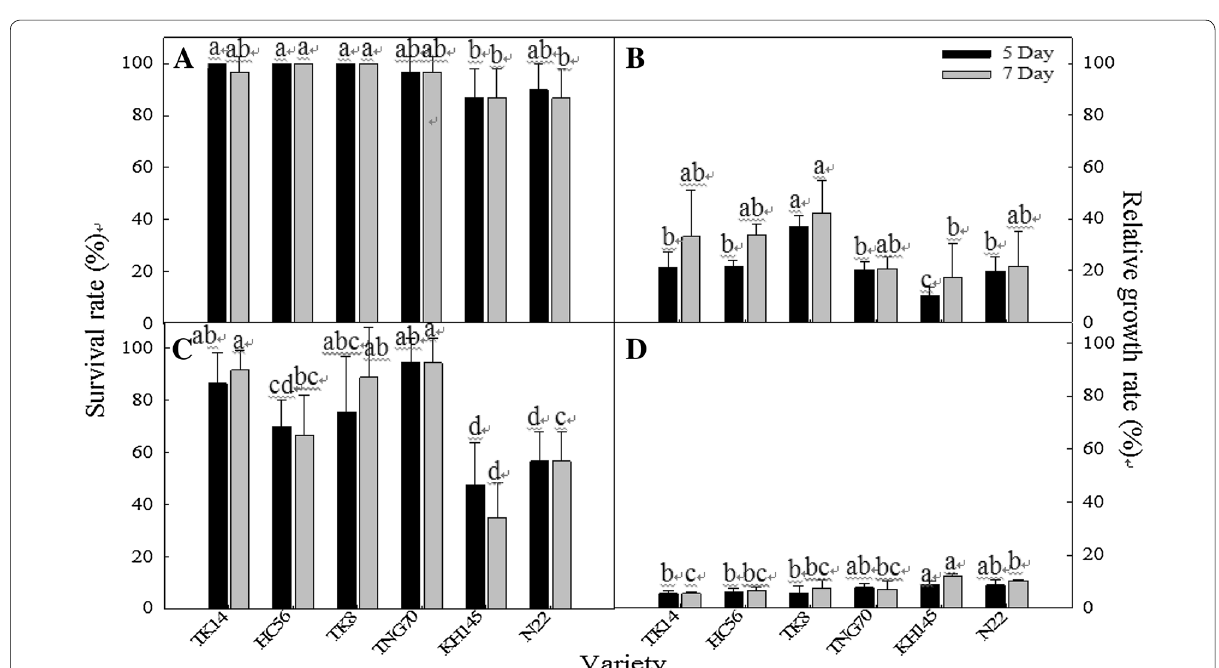
Fig. 7 Seedling survival rate and shoot RGR performance of pot‑cultivated rice 5 and 7 days after undergoing the TIR48 ( A , B ) and TIR50 ( C , D ) treatments. Different letters above the same color bars indicate a significant difference at the 0.05